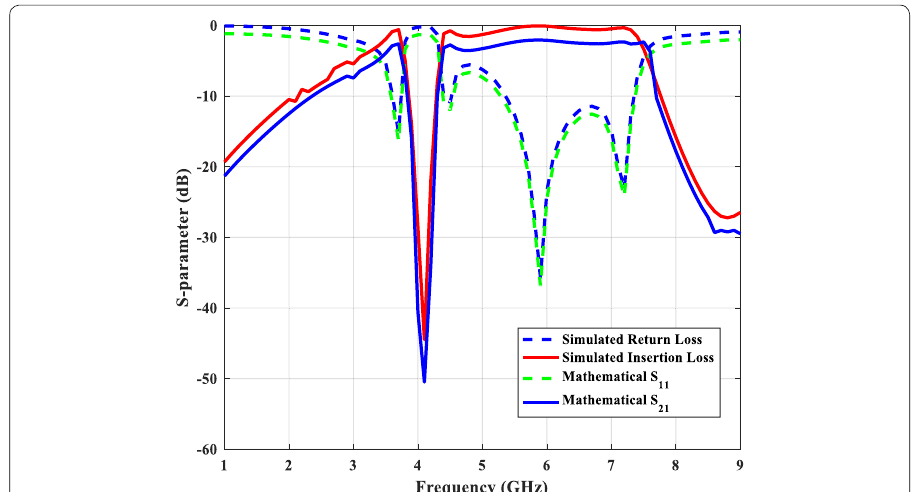
Fig. 6 Simulated S-parameter versus mathematical values of DB-BPF